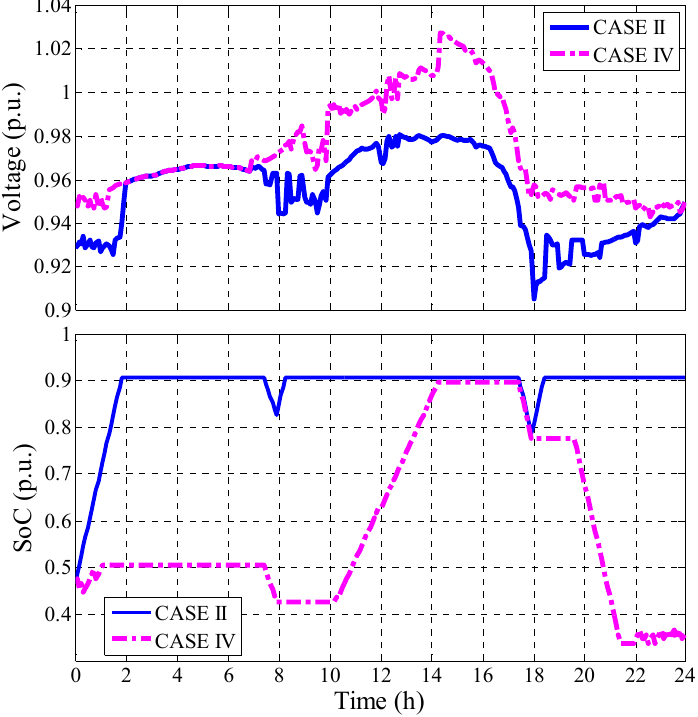
Figure 8. Voltage profile and SoC for bus 10: CASE II and CASE IV.